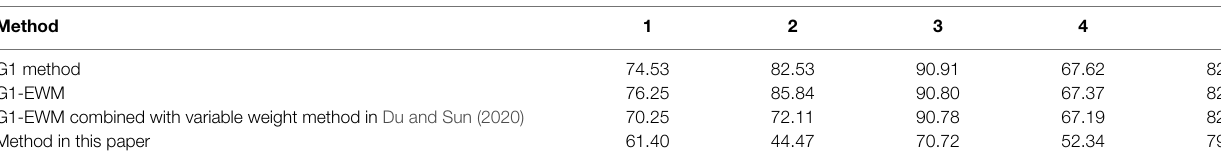
TABLE 10 | Comparison of assessment